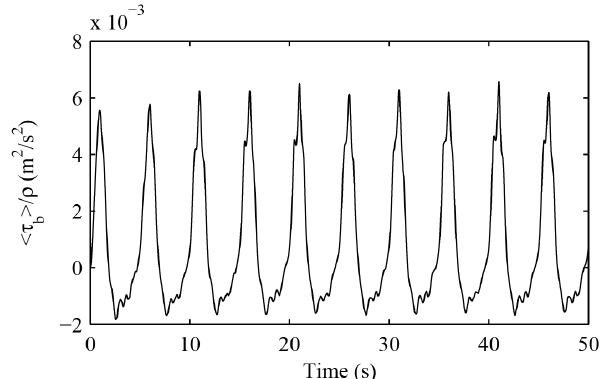
Figure 4. Time series of computed spatially averaged wall stress (Eq. 27) in the streamwise direction, assuming a surface rough- ness of z 0 = d 50 / 4. Note the rapid convergence to a quasi-steady